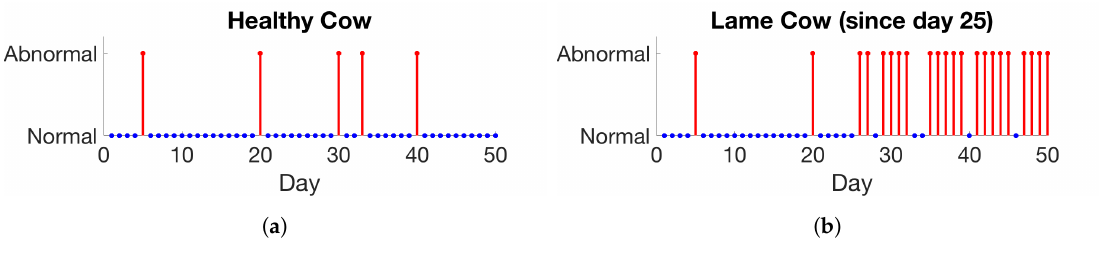
Figure 8. Visualization of the average classification performance of our approach for a cow walking normal ( a ) and after it becomes lame ( b